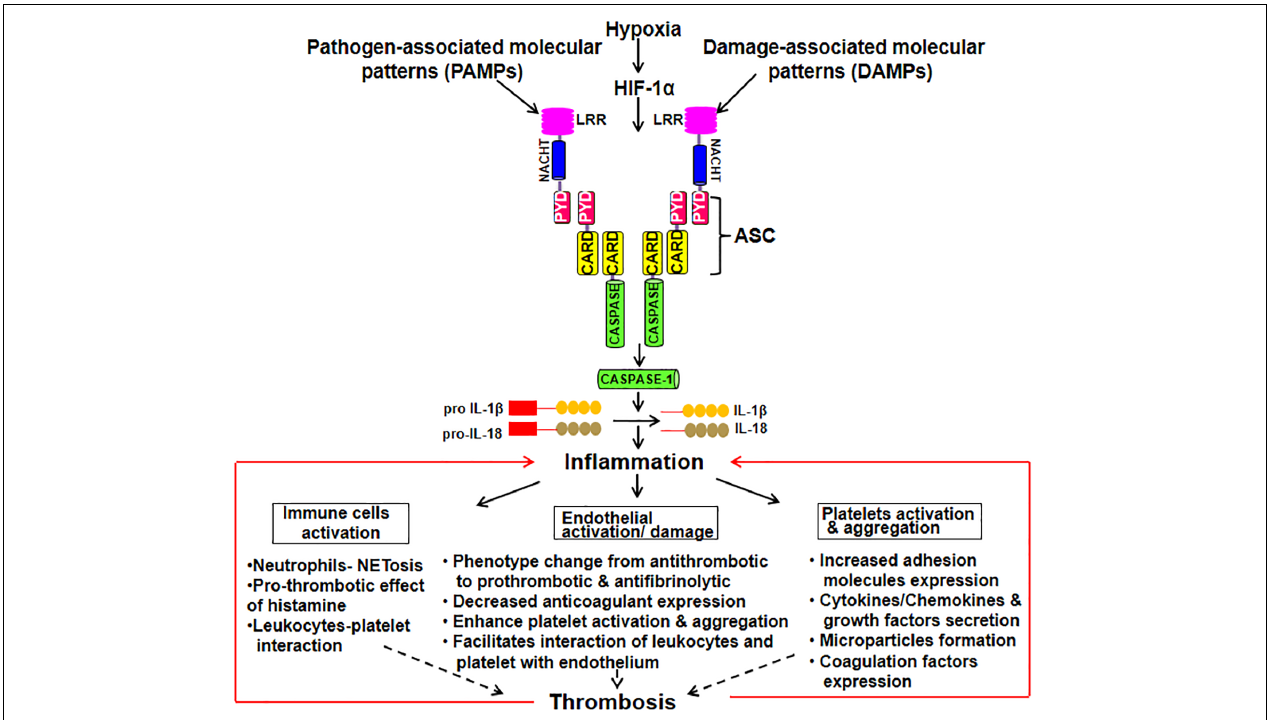
FIGURE 1 | Schematic depiction of inflammasome activation leading to the manifestation of thrombotic phenotypes. Inflammasome complex is a multimeric protein comprising of upstream sensor protein, an adaptor protein, and the cysteine protease procaspase-1. The sensor includes NLRs [Nucleotide-binding oligomerization domain (NOD) and leucine-rich repeat (LRR)-containing receptors] and the adaptor molecule ASC [an apoptosis-associated speck-like protein containing a caspase activation and recruitment domain (CARD)]. Upon exposure to DAMPs and PAMPs, inflammasome forms a complex. Procaspase-1 is recruited by ASC into the complex that converts it into its active form. Thus, caspase converts pro IL-1 β and IL-18 into their active forms leading to inflammation. This, subsequently, results in immune cells activation, endothelial damage and platelet activation and aggregation. All of these pro-thrombotic responses cumulatively lead to the thrombus